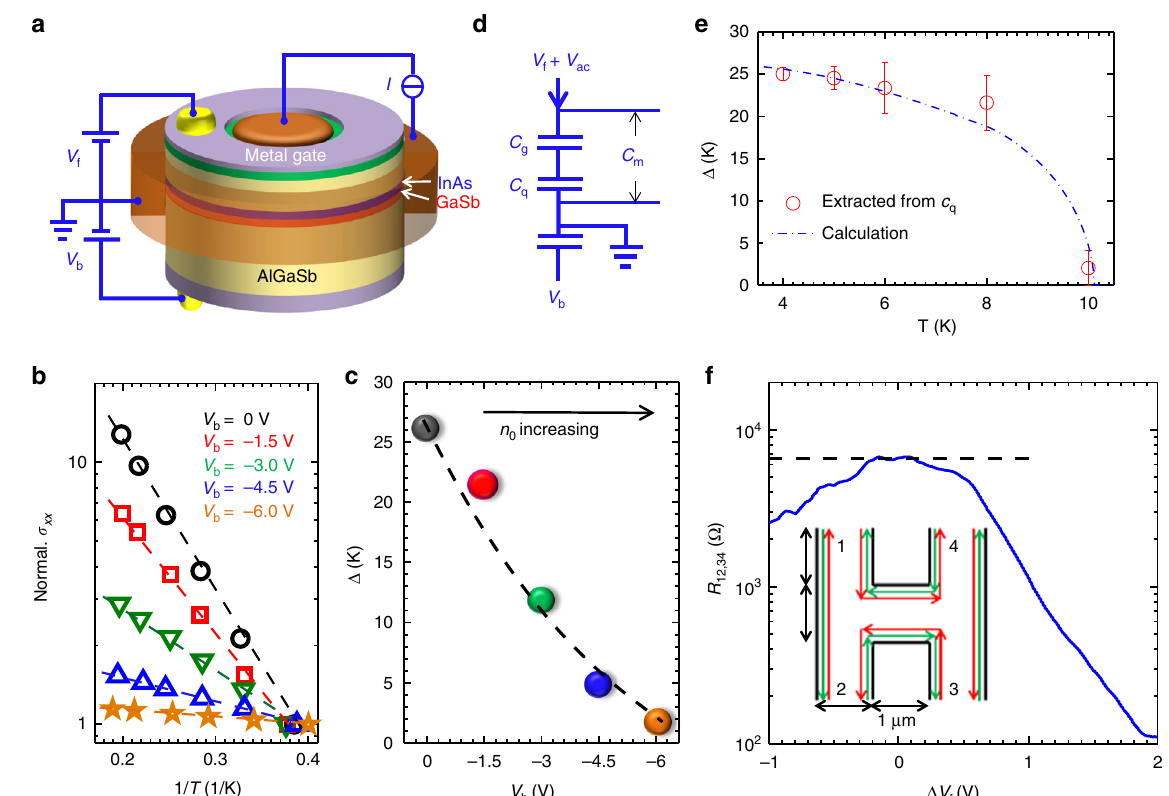
Fig. 3 Excitonic insulator gap and topological edge states. a Sketch of the measurement setup. b Arrhenius plot of the conductance minimum for different back-gate bias voltages. The data can be fi t by σ xx ∝ exp( − Δ /2 k b T ) to obtain Δ . Here the σ xx is normalized by its value at 2.5 K. Dashed lines are guides to the eye. Black circles are for V b = 0 V, red squares are for V b = − 1.5 V, green down-triangles are for V b = − 3 V, blue up-triangles are for V b = − 4.5 V, and yellow stars are for V b = − 6 V. c Measured gap energy Δ as a function of back-gate bias voltage. d Diagram for capacitance measurement. In addition to the dc V f and V b , a small low frequency ac voltage was applied to the front-gate, and the capacitance between the front-gate and the quantum wells was measured. e Gap energy as a function of temperature for V b = 0 V. At the charge-neutral point, the gap energies were extracted from c q . The dotted- dashed line is from the calculation. The error bars come from the uncertainties in c q and the temperature. f Nonlocal measurement performed in a mesoscopic H-bar for V b = 0 V at 0 T and 30 mK. The electrical current is passed through contacts 3 and 4, and the voltage is measured between contacts 1 and 2. The dashed line indicates the expected resistance value calculated from the Landauer – Büttiker formula. The edge current path is shown in the inset as red and green